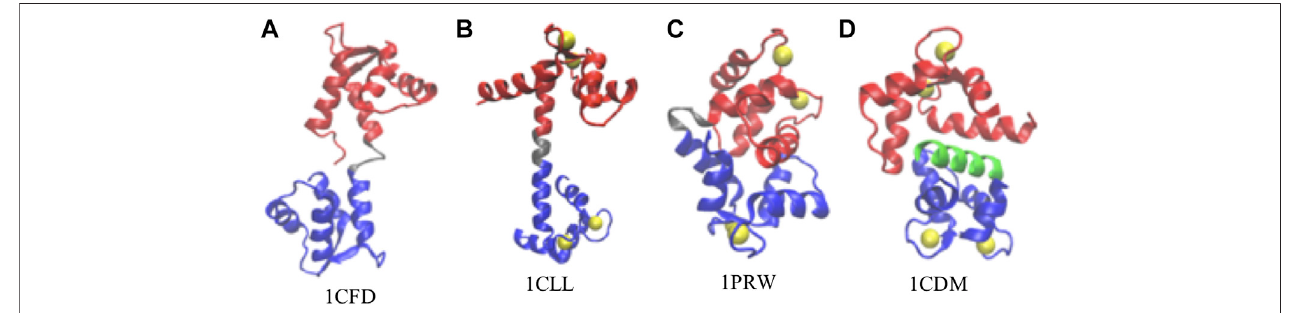
FIGURE 1 | Representative conformations of calmodulin (CaM). (A) Ca 2+ -free CaM, or apoCaM (PDB ID: 1CFD); (B) Ca 2+ -bound CaM, or holoCaM, in the extended conformation (PDB ID: 1CLL); (C) holoCaM in the collapsed conformation without a target peptide (PDB ID: 1PRW); (D) holoCaM with a target peptide (PDB ID 1CDM). We visualized the structures using the Visual Molecular Dynamics (VMD) program (Humphrey et al., 1996). Ca 2+ ions are shown in yellow spheres, the N-terminal and C-terminal domains of CaM are shown in red and blue, respectively, the central linker is shown in grey, and the target peptide is in green.